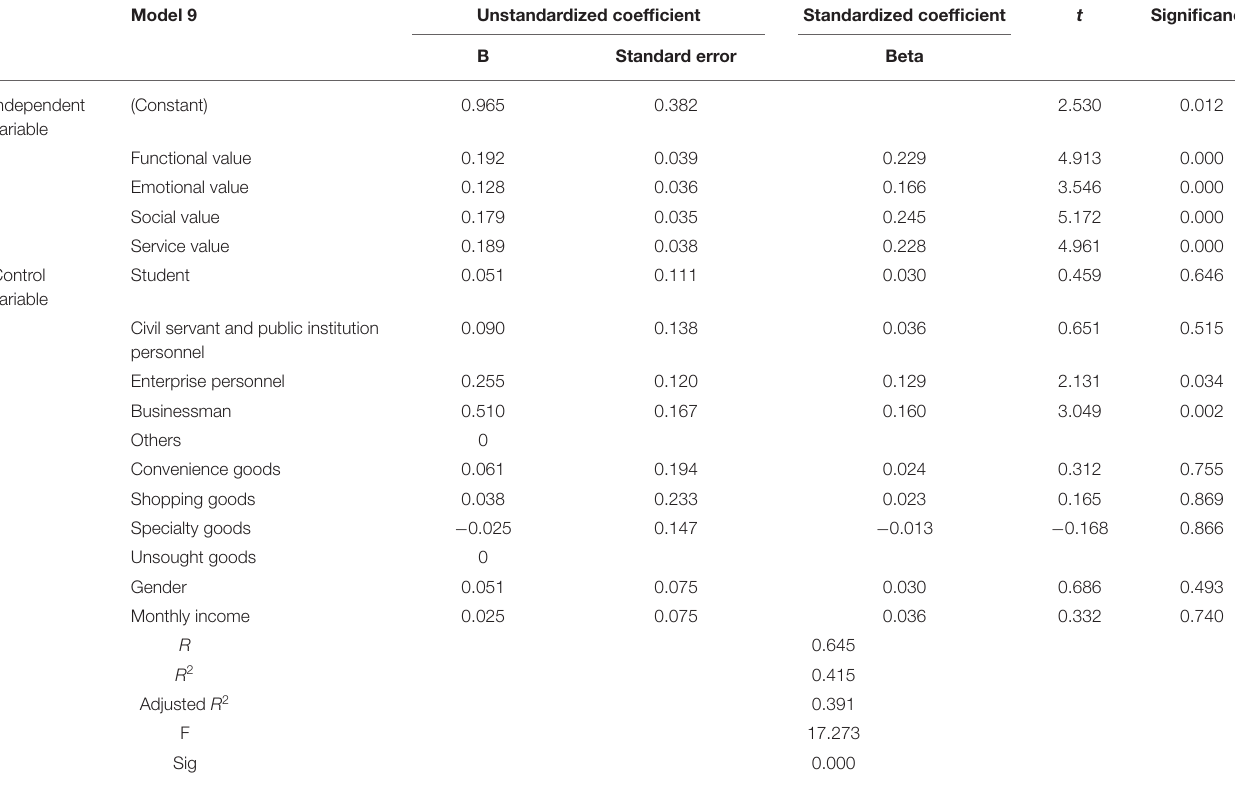
The dependent variable is the consumers’ purchase intention.